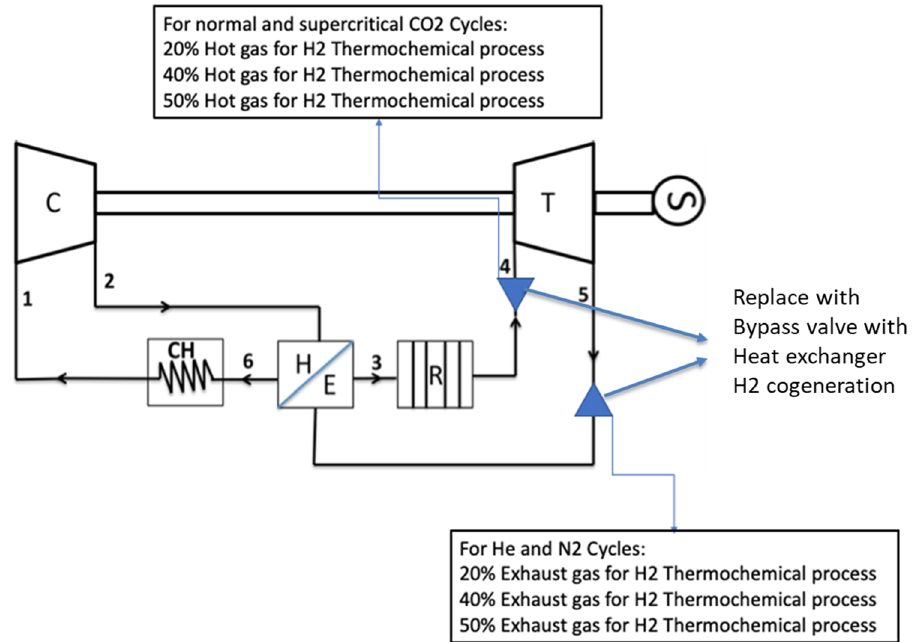
Figure 1. HTGR nuclear power plant cycle, with choice of several working fluids in a recuperated closed point. Point 1 and 2 represent the compression process; point 4 and 5 are the turbine expansion process; R is the reactor; H/E is the recuperator; and point 6 and 1 are the precooling process.